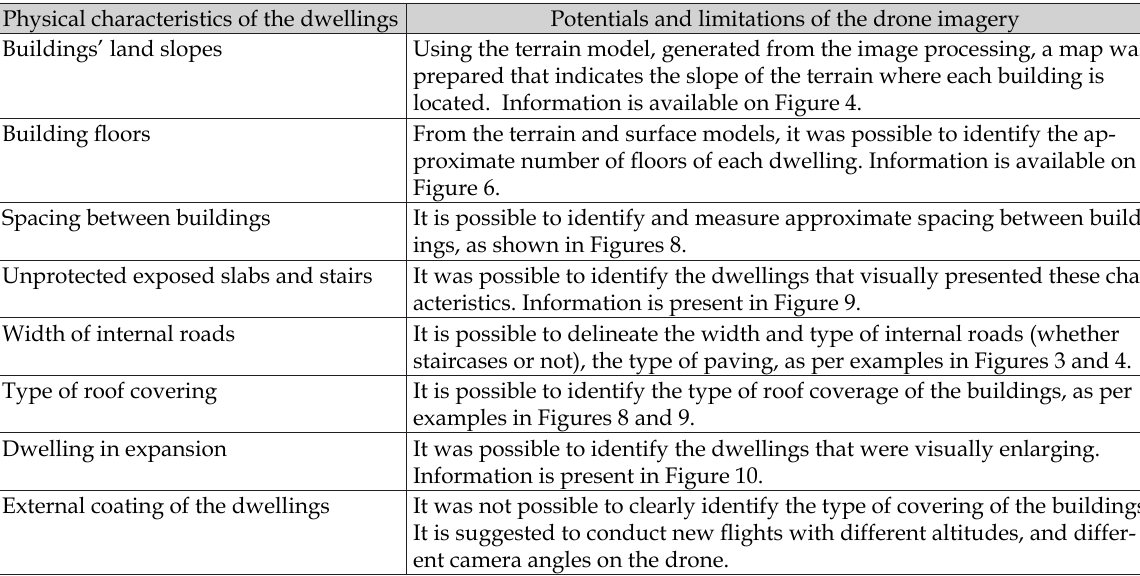
Fig. 10. Identification of dwellings been enlarged and with apparent unprotected slabs/stairs. Table 2. Drone collected data during the flight above the census sector in Alto das Pombas,